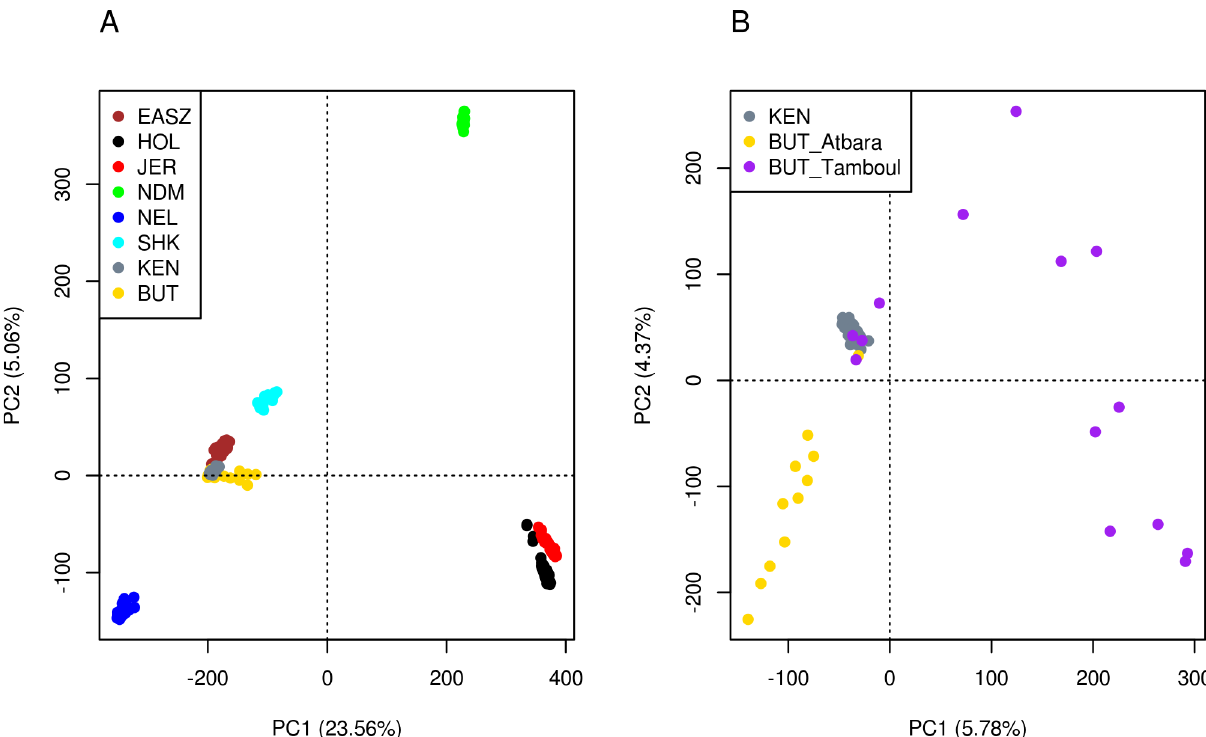
Fig 1. PCA plots showing the genetic relationship between cattle breeds. (A) all cattle breeds and (B) Butana and Kenanacattle.